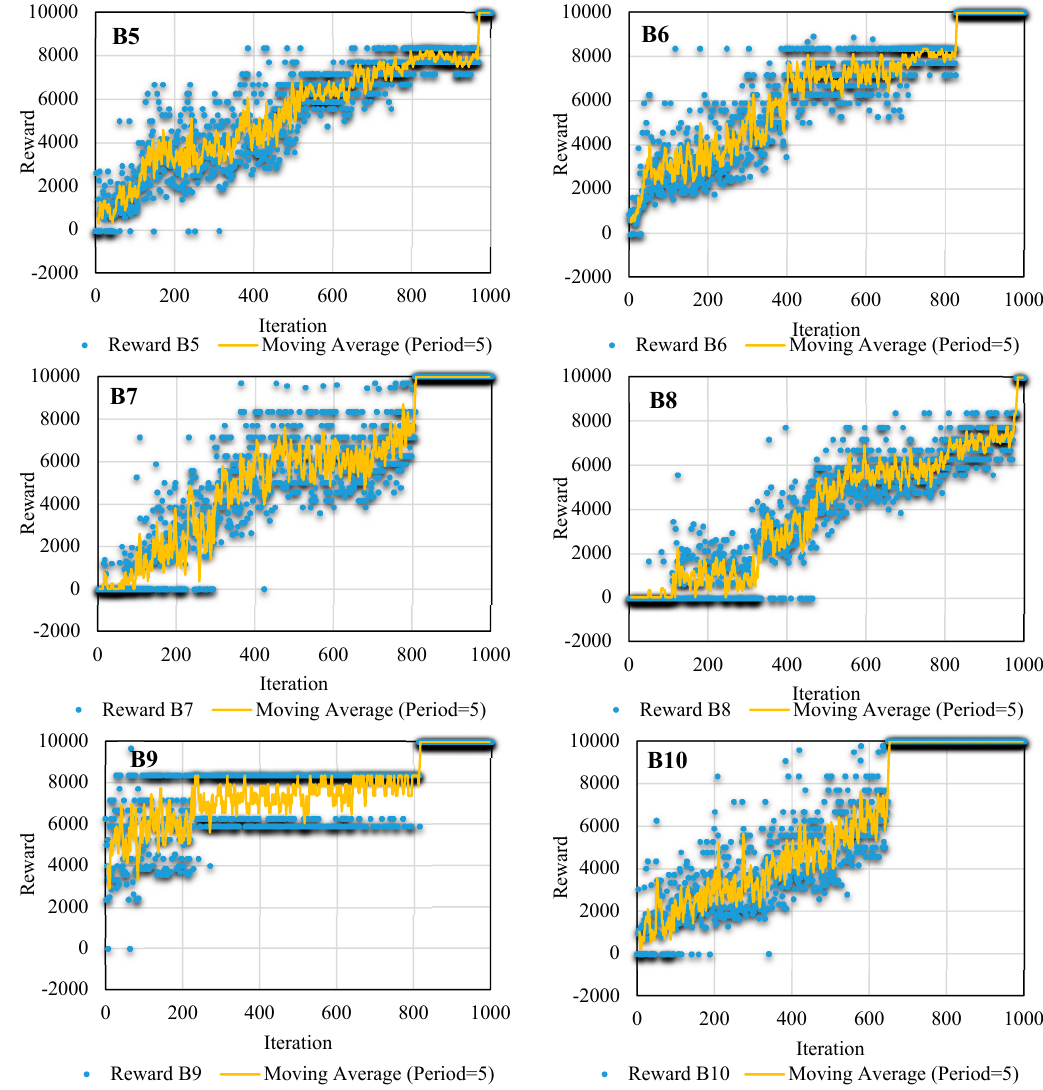
Figure 6. The fuzzy SARSA (state, action, reward, state, action) learning (FSL) convergence to the desired reward in different blocks.